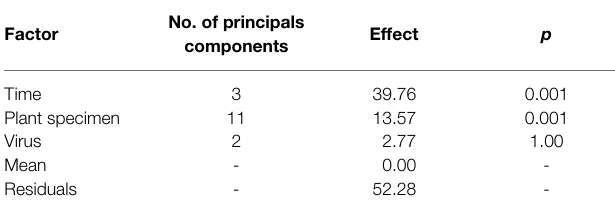
TABLE 2 | Results of ANOVA simultaneous component analysis (ASCA) elaboration on the complete data set of samples. Factor